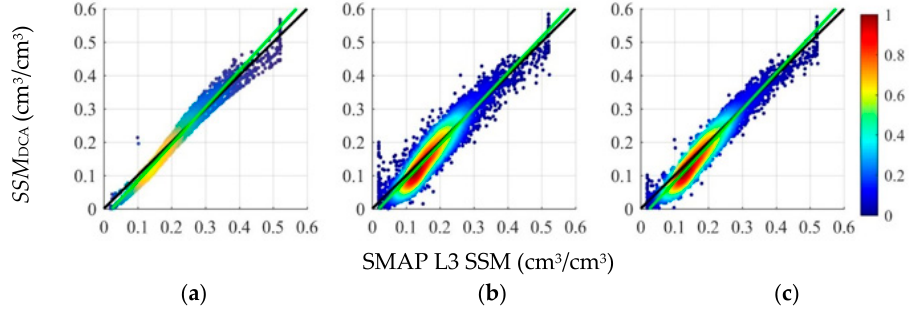
Figure 7. Comparison of SSM retrieved from the change detection algorithm (SSM DCA ) developed in this study and SMAP L3 SSM for V ( a ), H ( b ) and 0.5(H + V) ( c ) polarization for ascending orbit (N = 6631) from 2016–2018. The color of the colorbar indicates the point density of SSM DCA and SMAP L3 SSM.